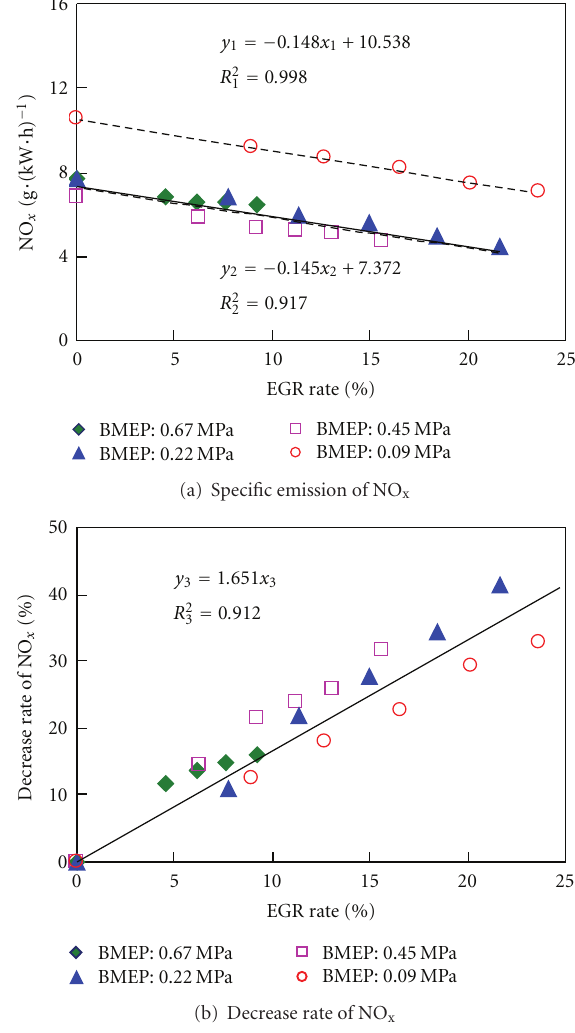
Figure 6: The specific emissions of NO x varying with EGR rate.